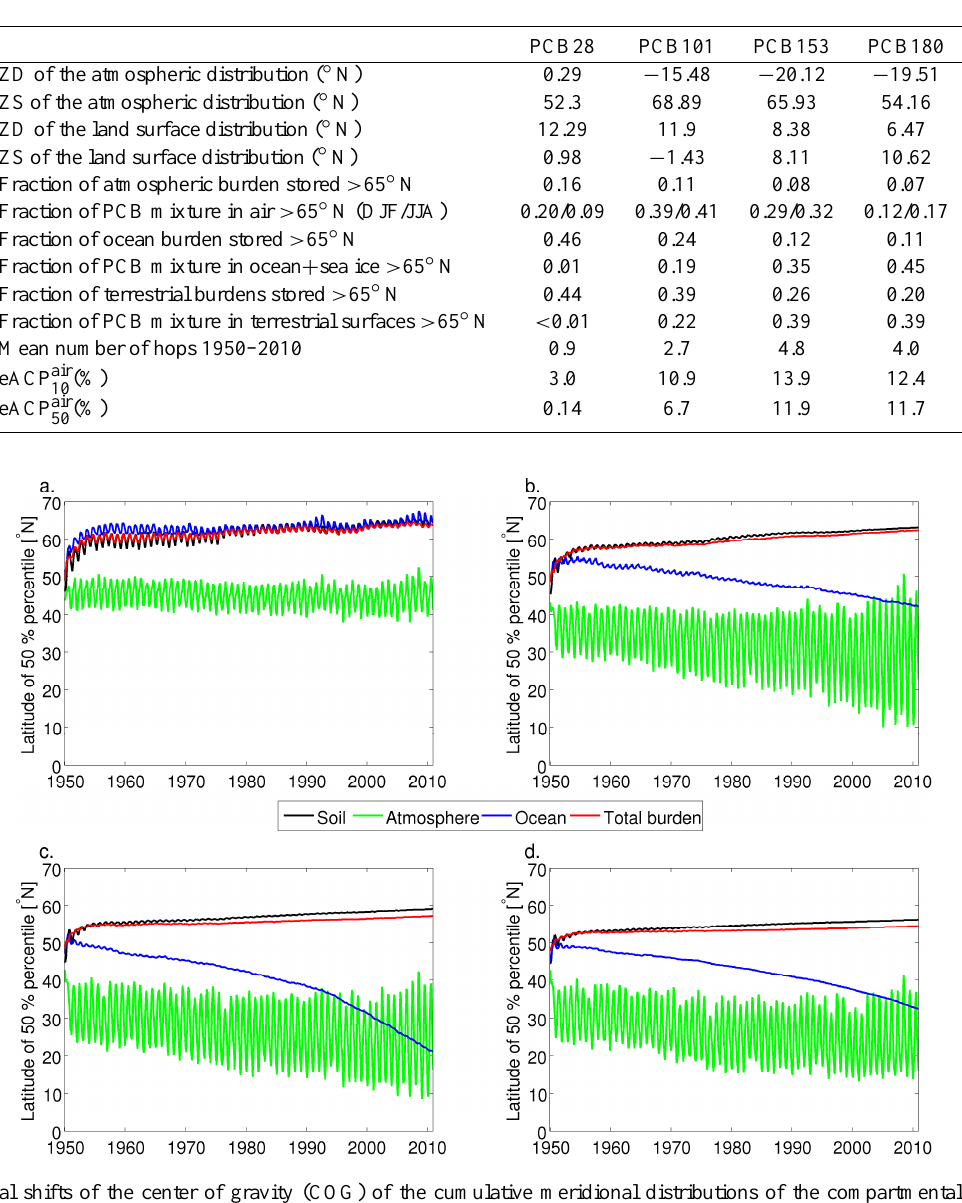
Table 1. Indicators for meridional distribution, fractionation and long-range transport (LRT). ZD = zonal displacement, ZS = zonal spread- ing, eACP = Arctic contamination potential normalized to accumulated emissions. Distribution refers to the total compartmental burden. Mean of last year of the simulation, 2010. ZD and ZS of the emissions are 0.79 and 33.29 ◦ N for all substances.